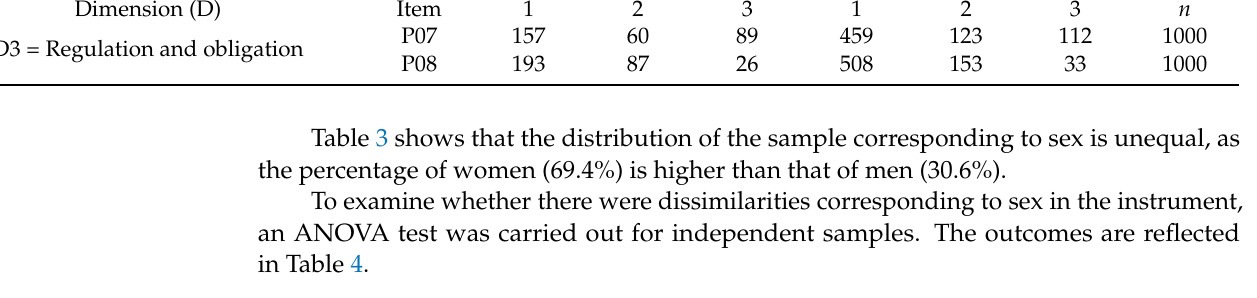
Table 4. ANOVA for independent samples based on sex for dimension D3.